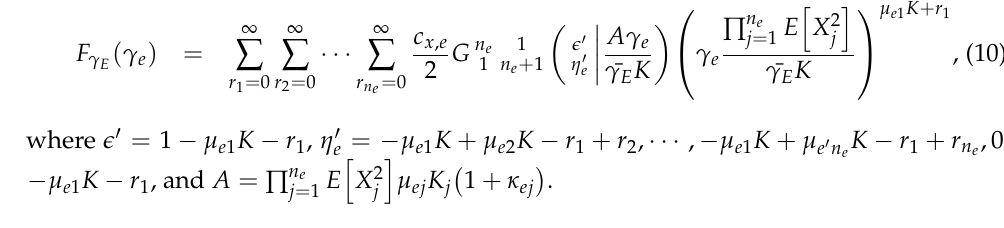
where (cid:101) (cid:48) = 1 − µ e 1 K − r 1 , η (cid:48) − µ − r e 1 K 1 , and A